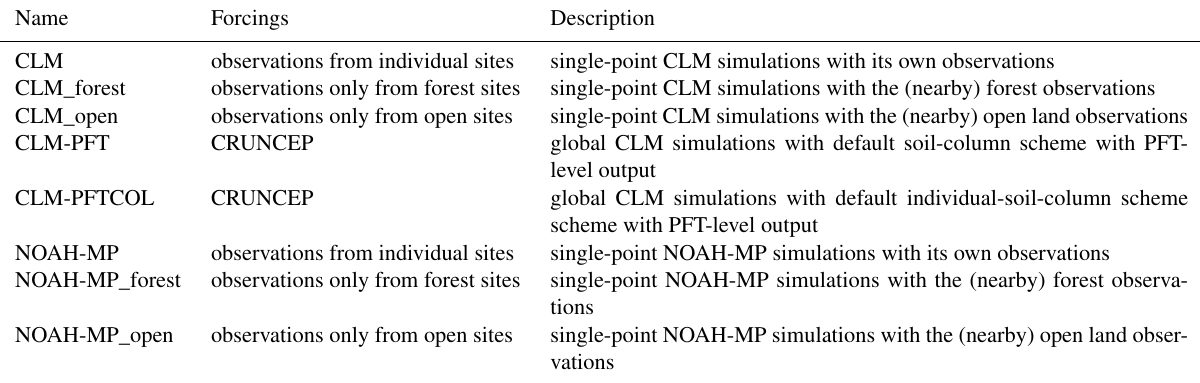
Table 2. Information about model simulations. “Nearby” observations indicate that the paired sites have the identical forcings either from the companion forest or open